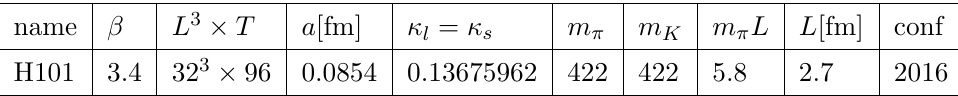
Table 1 . Parameters of the H101 CLS ensemble used in the present